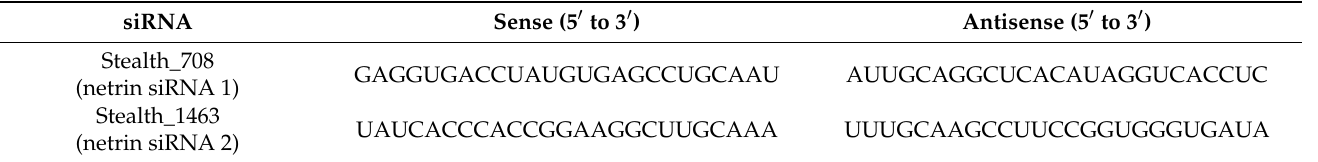
Table 1. Stealth RNAi siRNA strands for mouse netrin-1 genes. Sense (5 (cid:48) to 3 (cid:48) ) Antisense (5 (cid:48) to 3 (cid:48)